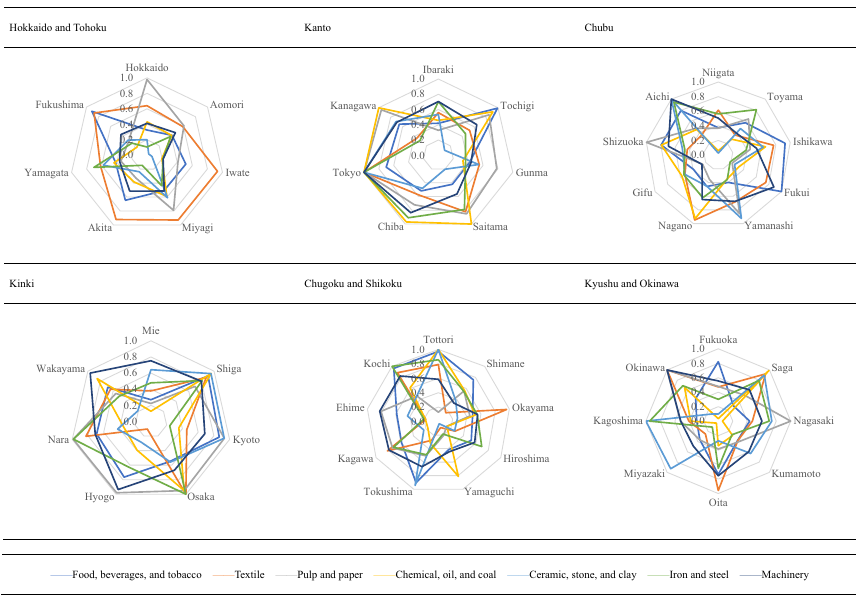
variables, GDPC stands for gross domestic product (GDP) per capita, IS is the industry share, and EI is the energy intensity. η i is the unobservable fixed effect by prefecture, μ t is the linear trend showing a common time effect, and ε is an error